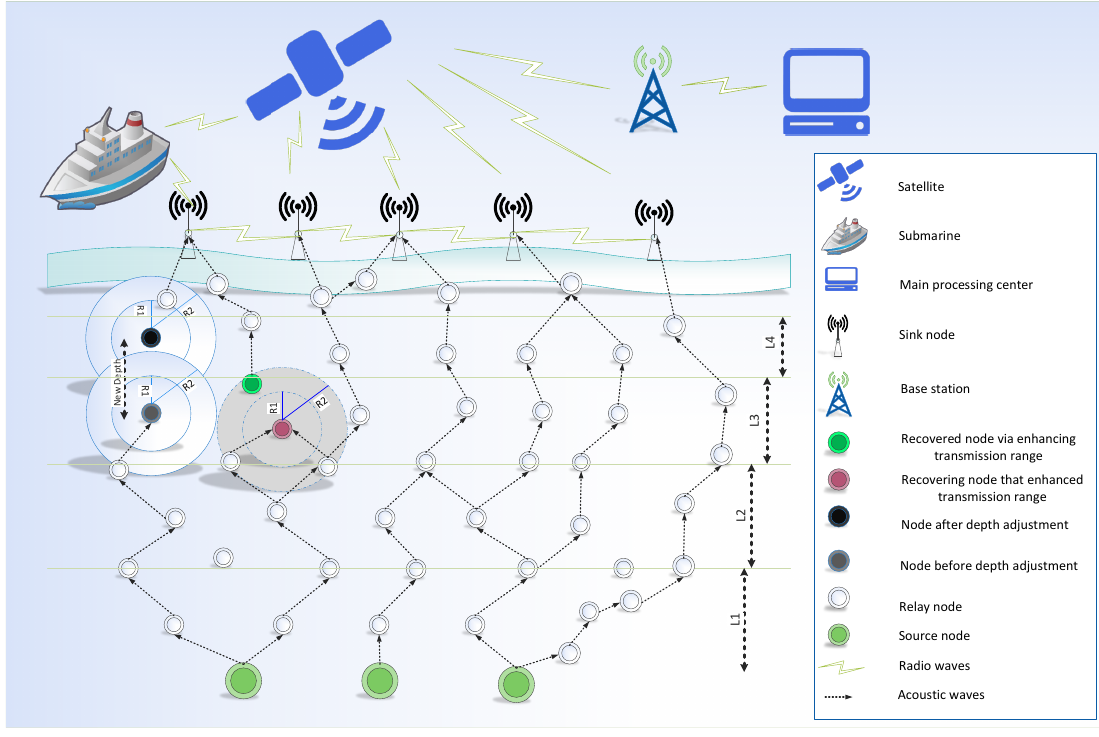
Figure 1. Proposed system